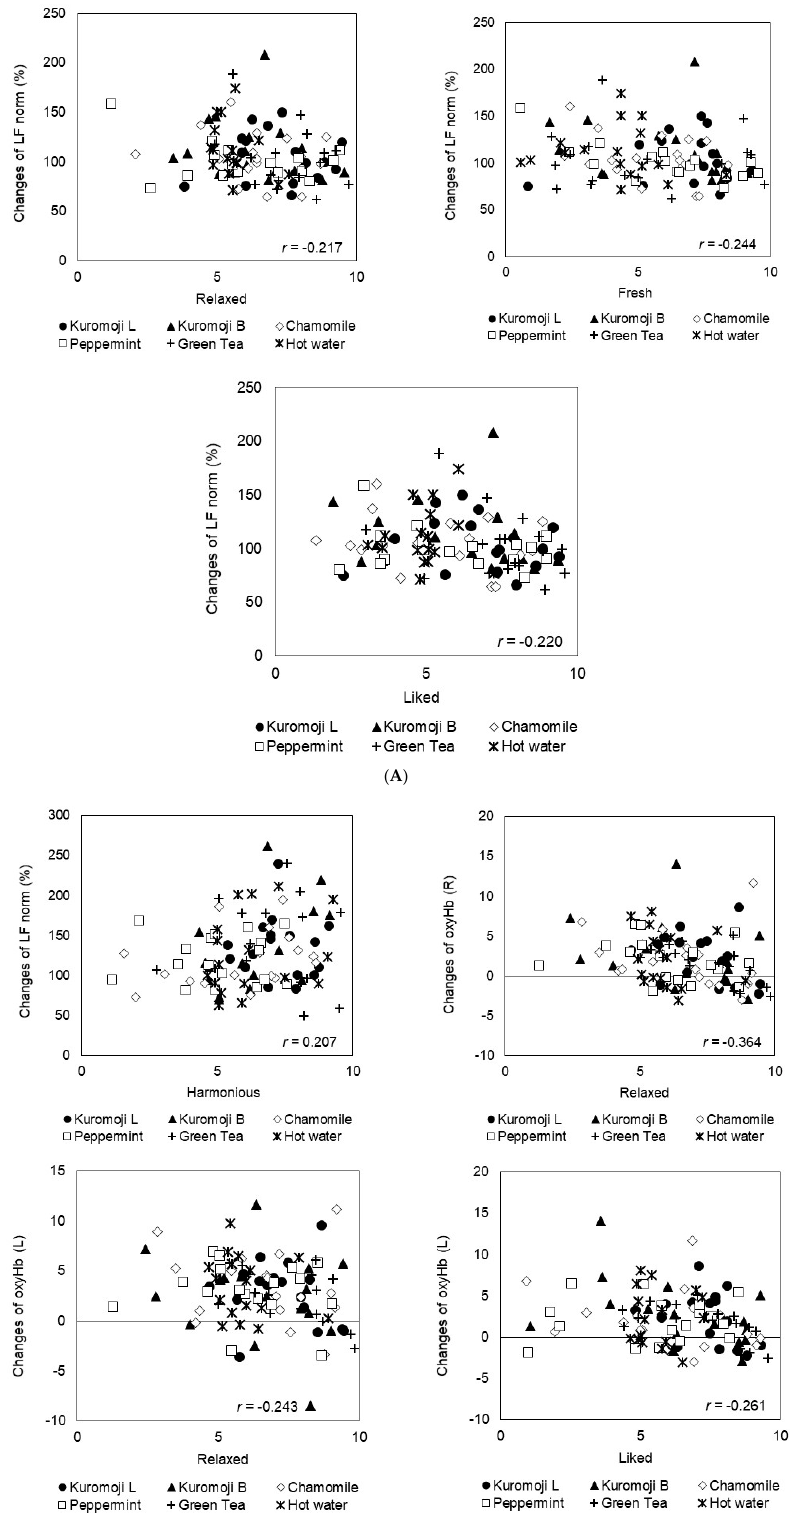
Figure 3. Relationships between subjective feelings and physiological responses. Plots represent the relationships between the values of LF norm or oxyHb and the subjective assessments in experiment 1 ( A ) and 2 ( B ). Regarding experiment 1, a significant correlation between the decrease of sympa- thetic nervous activity and increase of relaxation, freshness and the favoring of a specific tea in the subjective assessments was shown. Our results indicated that the aroma has the potential to induce physiological relaxation before drinking the tea. Many previous re- ports have indicated that sniffing a pleasant aroma could reduce sympathetic nervous activity and increase physiological relaxation [32–35].